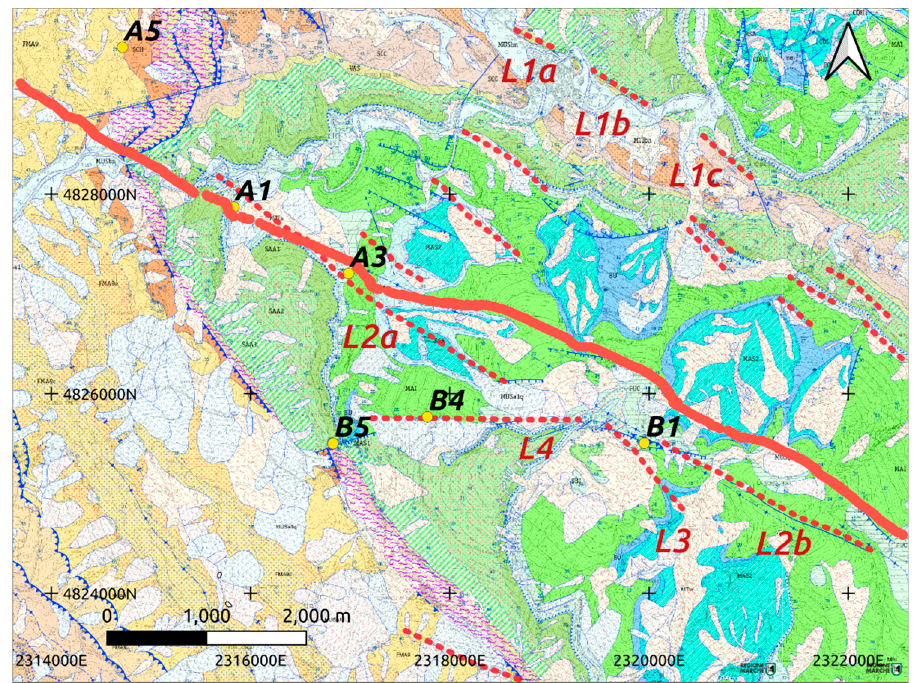
Figure 11. The tentative topographic trace of the Sassorotto fault (thick red trace), as interpolated using a trial-and-error search method with a DEM–plane intersection module implemented in the qgSurf plug-in. The geological plane that fit the A1 and A3 sites had a dip direction of 205° and a plunge of